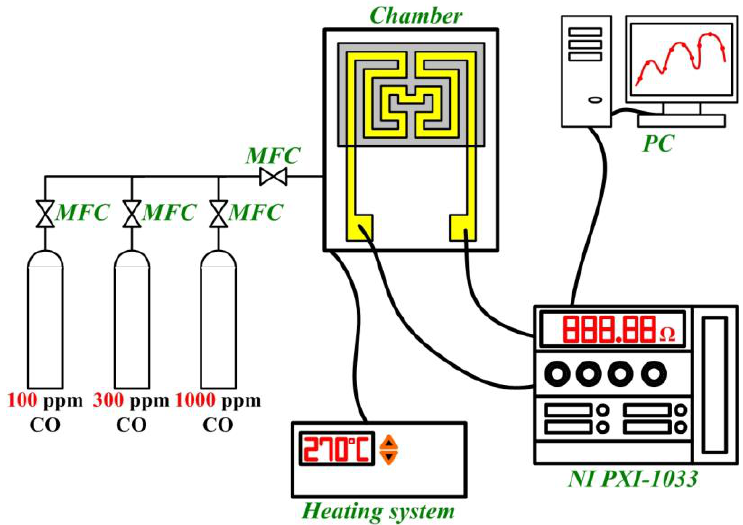
Figure 4. Relation between temperature and sensitivity for various SnO